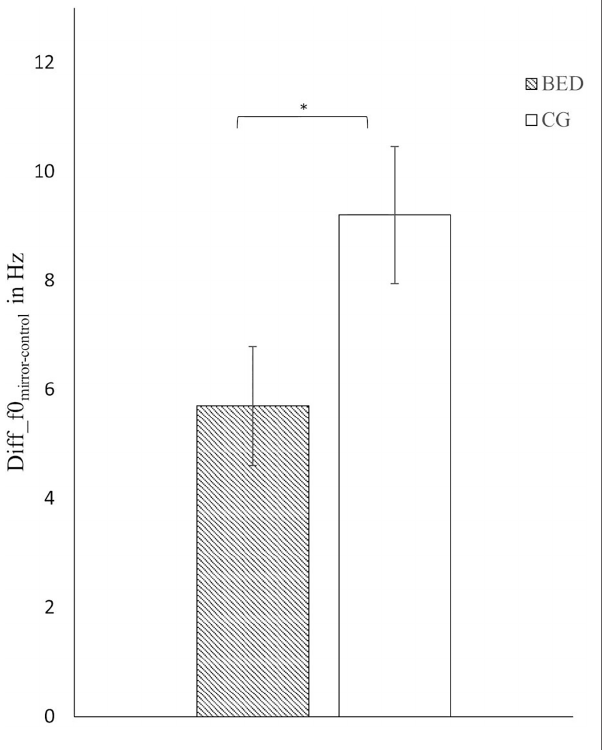
FIgURE 1 | Mean and standard error for the difference score in mean f0 between the mirror exposure and control condition in the BED and the control group (CG). *p <